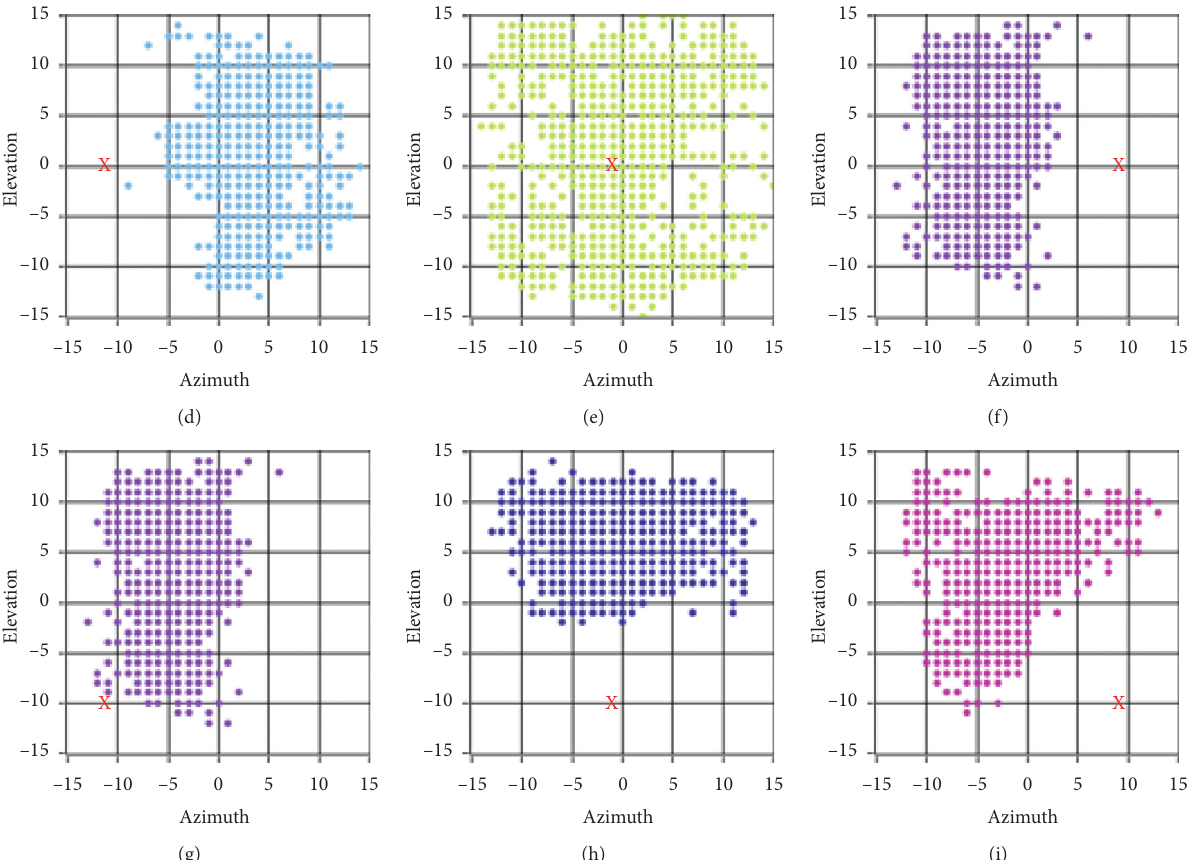
Figure 7: Maximum positions of the acoustic images of fan matrix with one faulty fan (the position of this faulty fan is represented with a cross). (a) Fan 1. (b) Fan 2. (c) Fan 3. (d) Fan 4. (e) Fan 5. (f) Fan 6. (g) Fan 7. (h) Fan 8. (i) Fan 9. Table 1: SVM accuracy rates of the robustness tests for the one faulty fan detection methodology based on training the SVM with one faulty fan parameters. One faulty fan